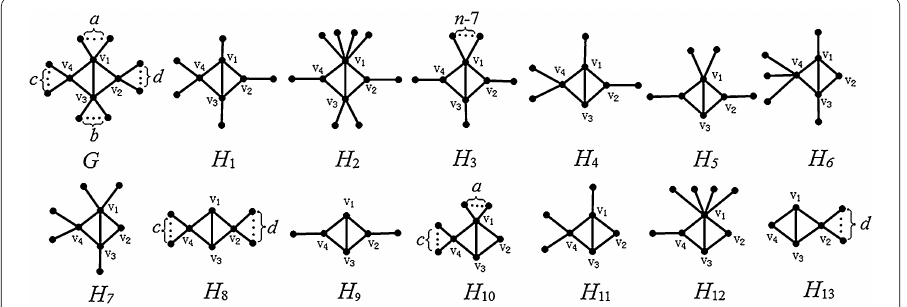
Figure 13 Some bicyclic graphs with θ (2,3,3) as their